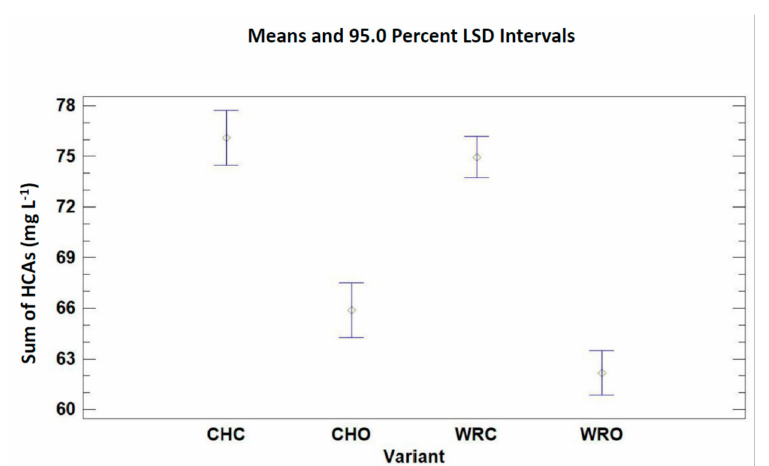
Figure 9. Significant differences between the sum of the hydroxycinnamic acids (HCAs) in wine in wine and the varieties and all